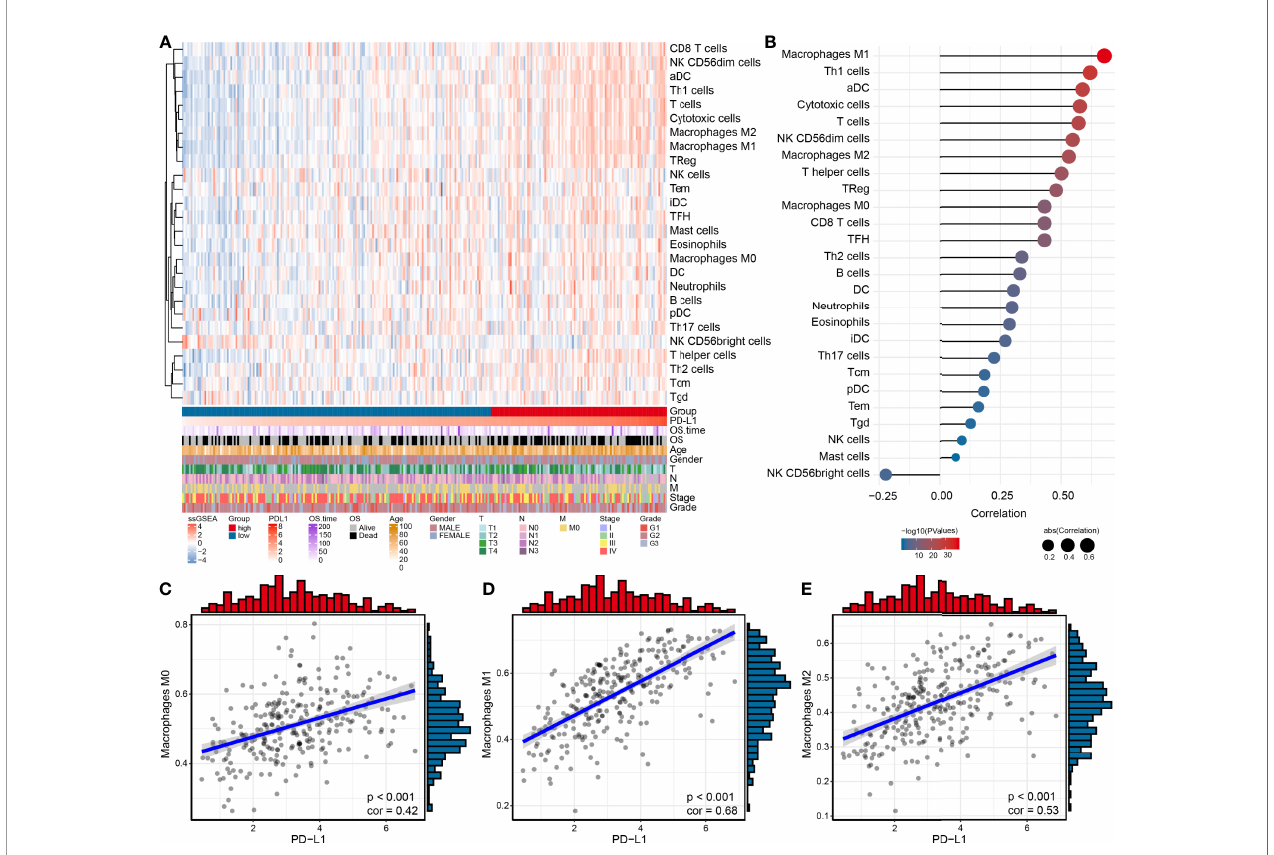
FIGURE 3 | Relationship between immune cell in fi ltration and PD-L1 expression in OSCC samples. (A) Heat map by using the ssGSEA scores from 26 immune cell types. (B) Correlation between PD-L1 and immune in fi ltrates in OSCC samples. Correlation between PD-L1 and M0 (C) , M1 (D) and M2 (E) macrophages in fi ltration in OSCC